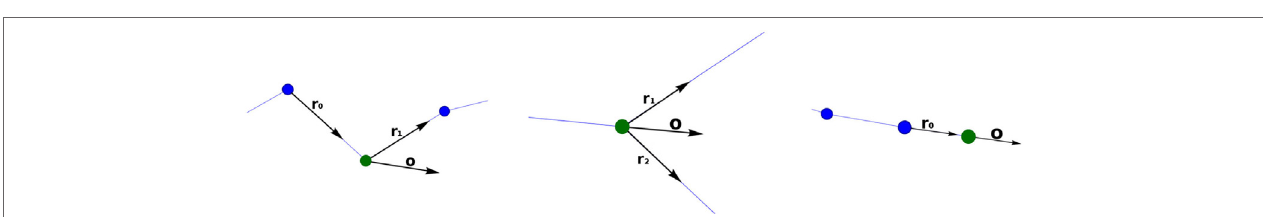
FIGURe 4 | Calculating the orientation vector according to the different types of tracing points. The current point is represented with a green sphere. Left image: standard tracing point. Middle image: bifurcation tracing point. Right image: ending tracing